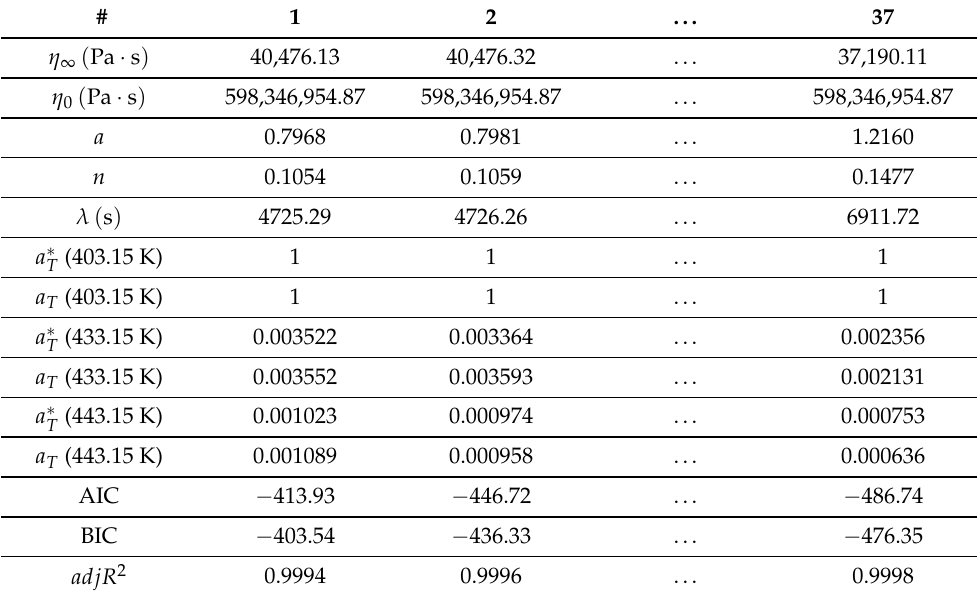
Table 1. Evolution of the estimated parameters of the Carreau–Yasuda model and TTS shift factors with each iteration (Scenario 1). The values shown for item #1 are referred to as the traditional method in this work.